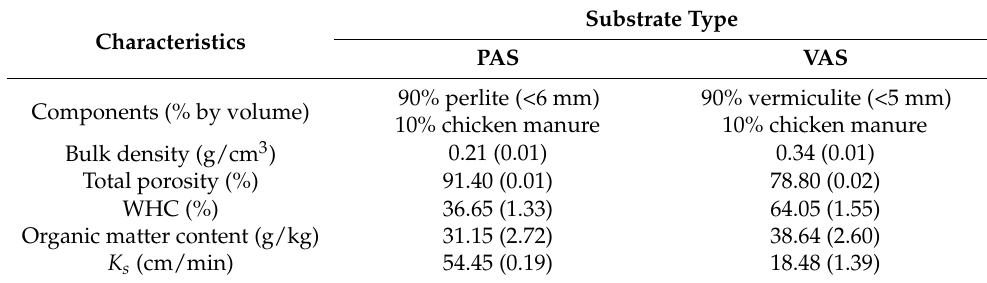
Table 1. Characteristics of the artificial substrates [mean (SE)].